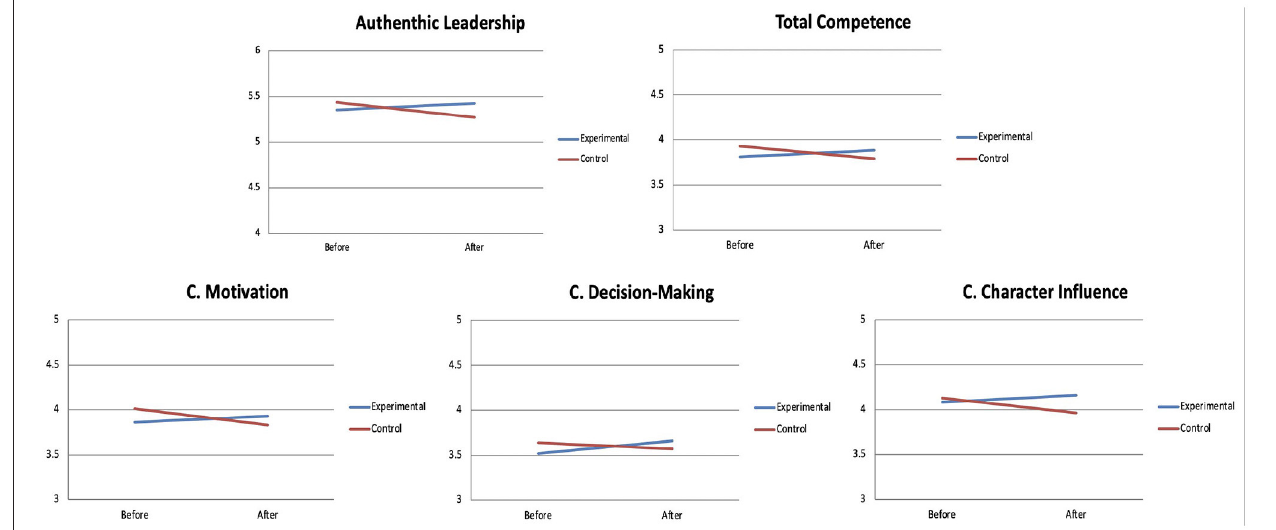
FIGURE 2 | Significant interactions between the time of measure (before vs. after the intervention) and the group (experimental vs. control) for the